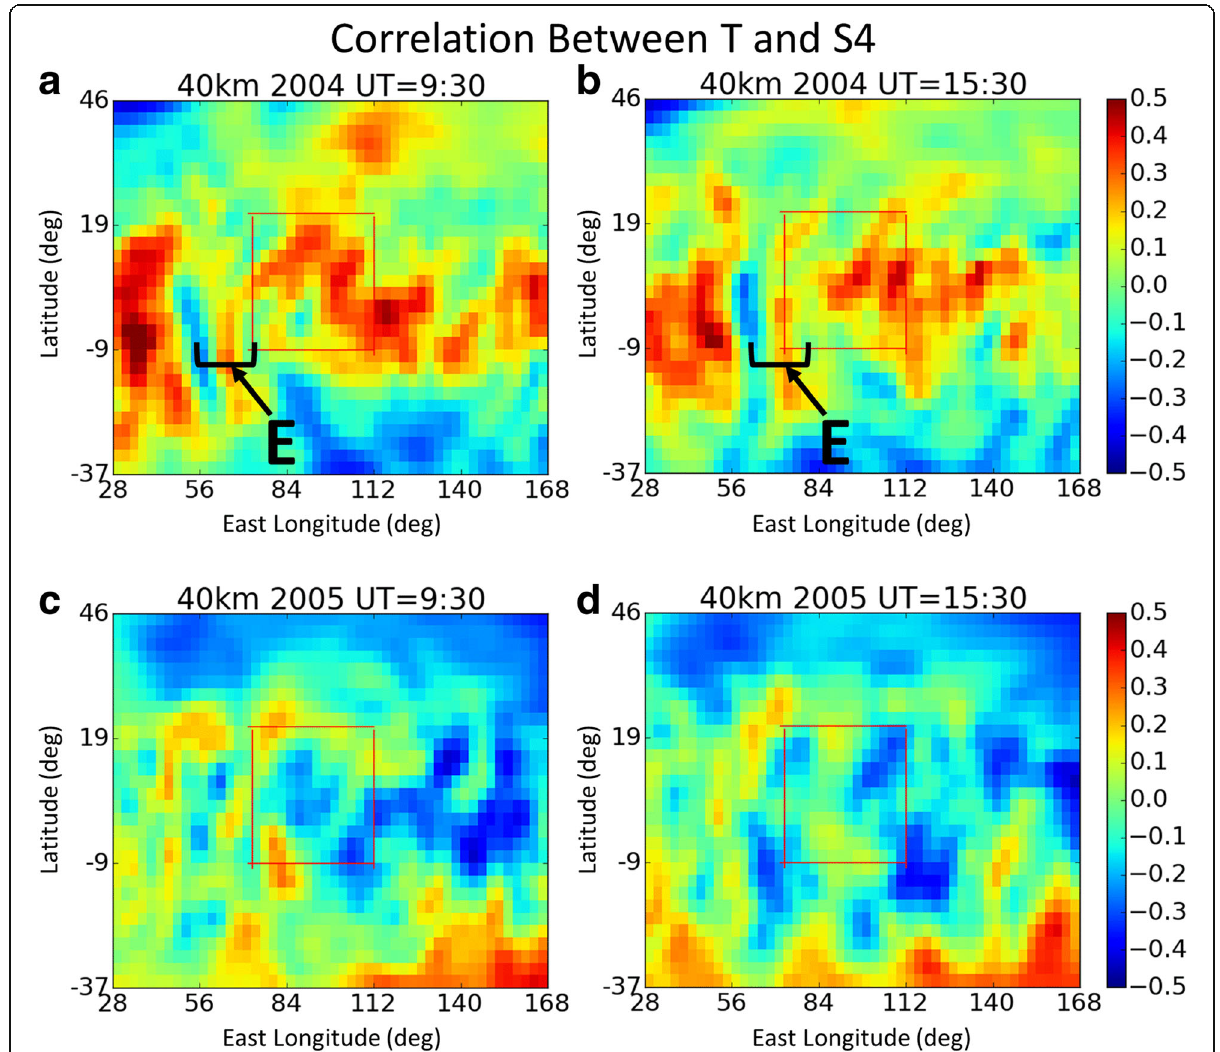
Fig. 3 The same as Fig. 2 except for data in March and April 2004 and March and April 2005. The altitude is fixed at 40 km for all panels. a